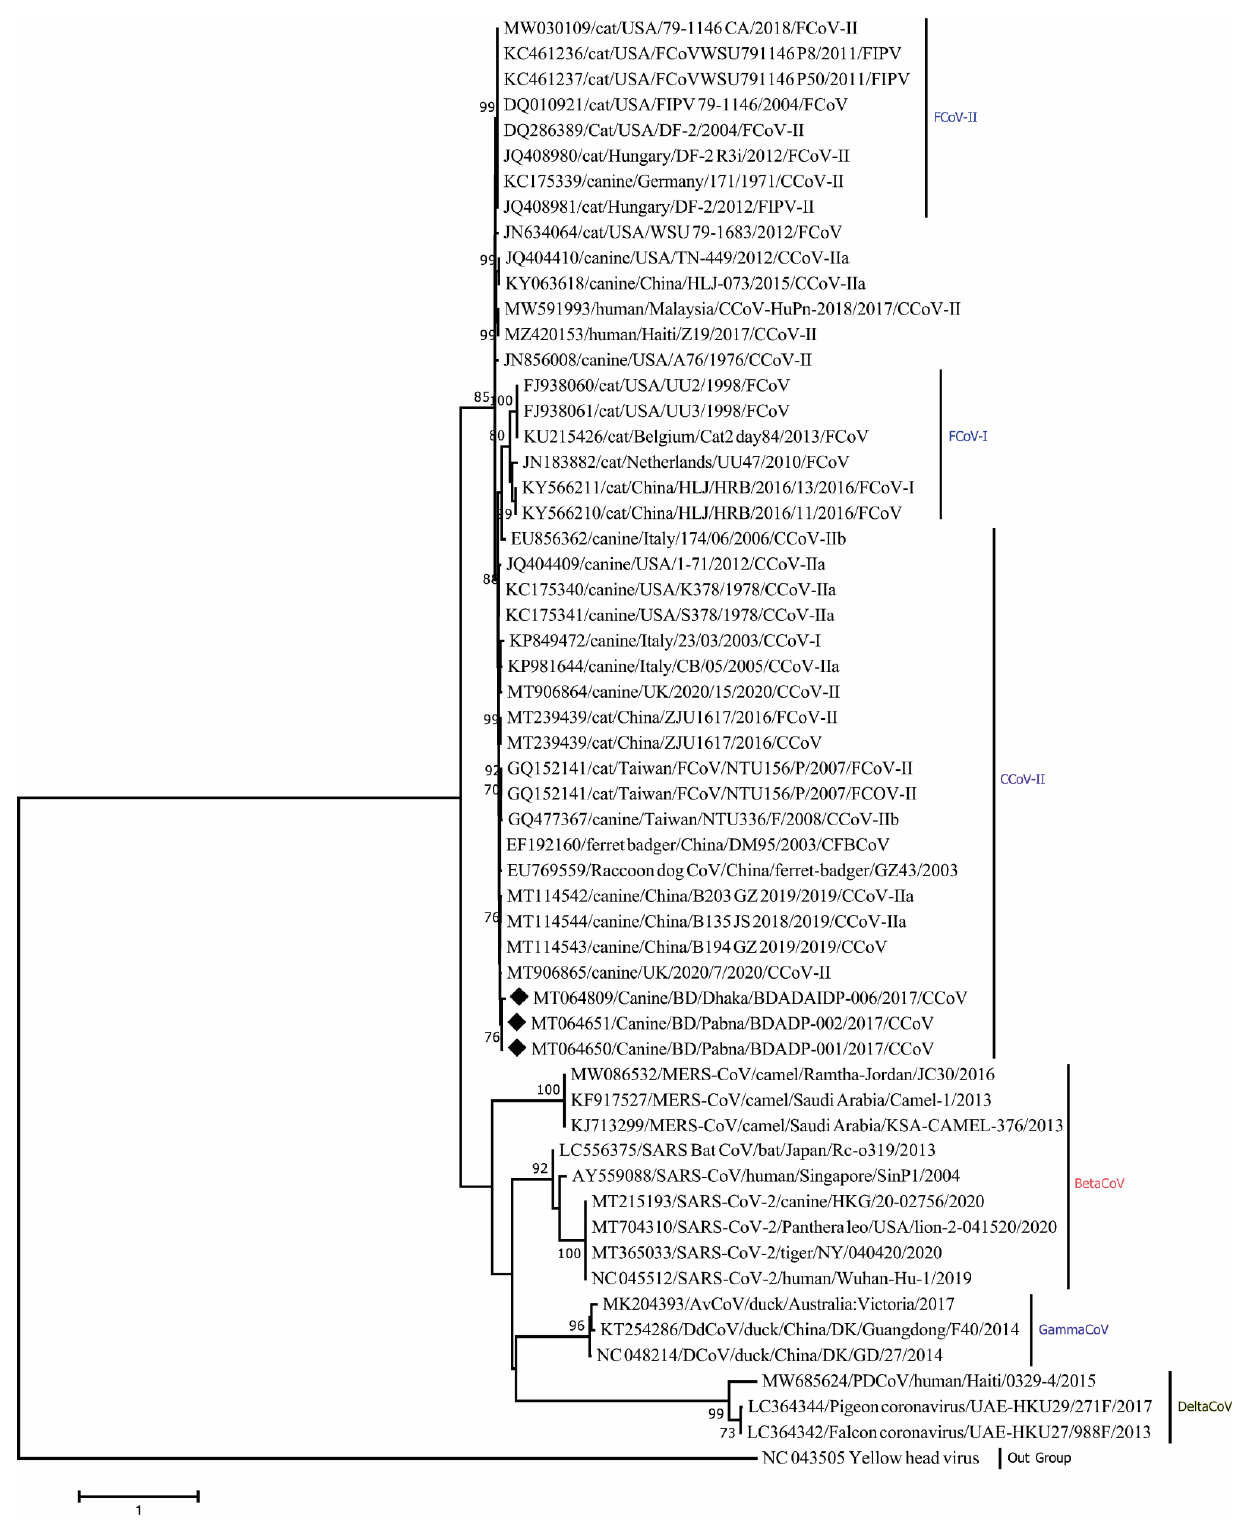
Figure 3. Maximum Likelihood phylogenetic tree based on the partial nonstructural protein 14 (Nsp14) sequence of Coronaviridae. CCoV strains in this study are indicated by rhombus (blue colored). Canine CoV, feline CoV, Betacoronavirus, Gammacoronavirus, Deltacoronavirus sequences are shown in the phylogeny. The tree was calculated using the Maximum Likelihood method with the Kimura 2-parameter distance model. The percentages of replicate trees (>70%) in which the associated taxa clustered together in the bootstrap test (1000 replicates) are shown next to the branches.